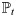
Dynamic change in response to the IFN-β signal.(A-C) Activities of N2- and N1-modules in response to IFN-β levels (S) when the TGF-β level is low (G = 0.1 in (A)), intermediate (G = 0.5 in (B)), and high (G = 0.65 in (C)). When the TGF-β level is low or intermediate, there exists a bi-stable window (WS = {S ∈ [0, 1]: Sm ≤ S ≤ SM}) where both Pt and Pa coexist. (D) For a constant IFN-β signaling, the system transits from Pa- to Pt-modes as the TGF-β level is increased. On the other hand, for a fixed TGF-β level, an increase in S induces a transition from Pt-favoring mode to the Pa-status. Other parameters are given in Table 2.